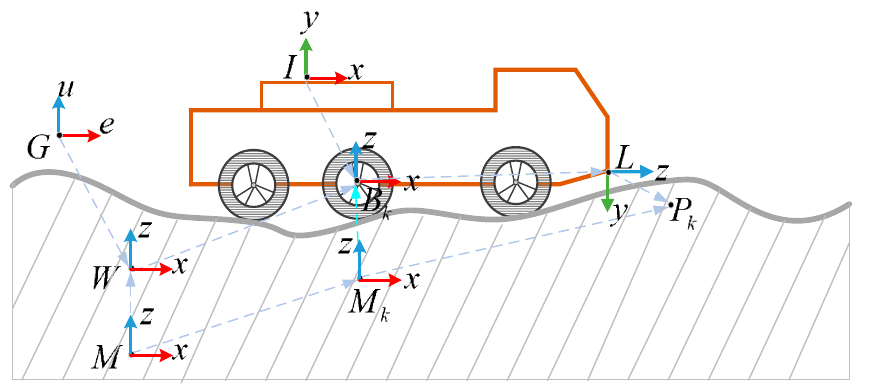
Figure 3. Automobile coordinate system.